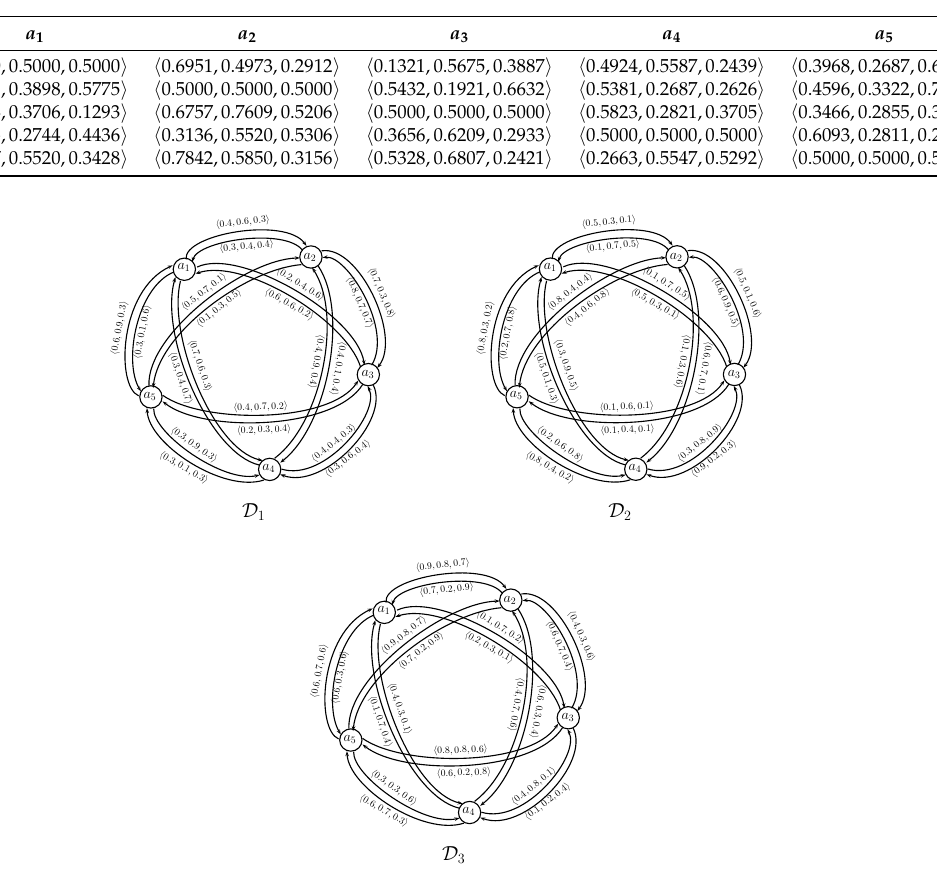
Table 4. The collective SVNPR of all the above individual SVNPRs.